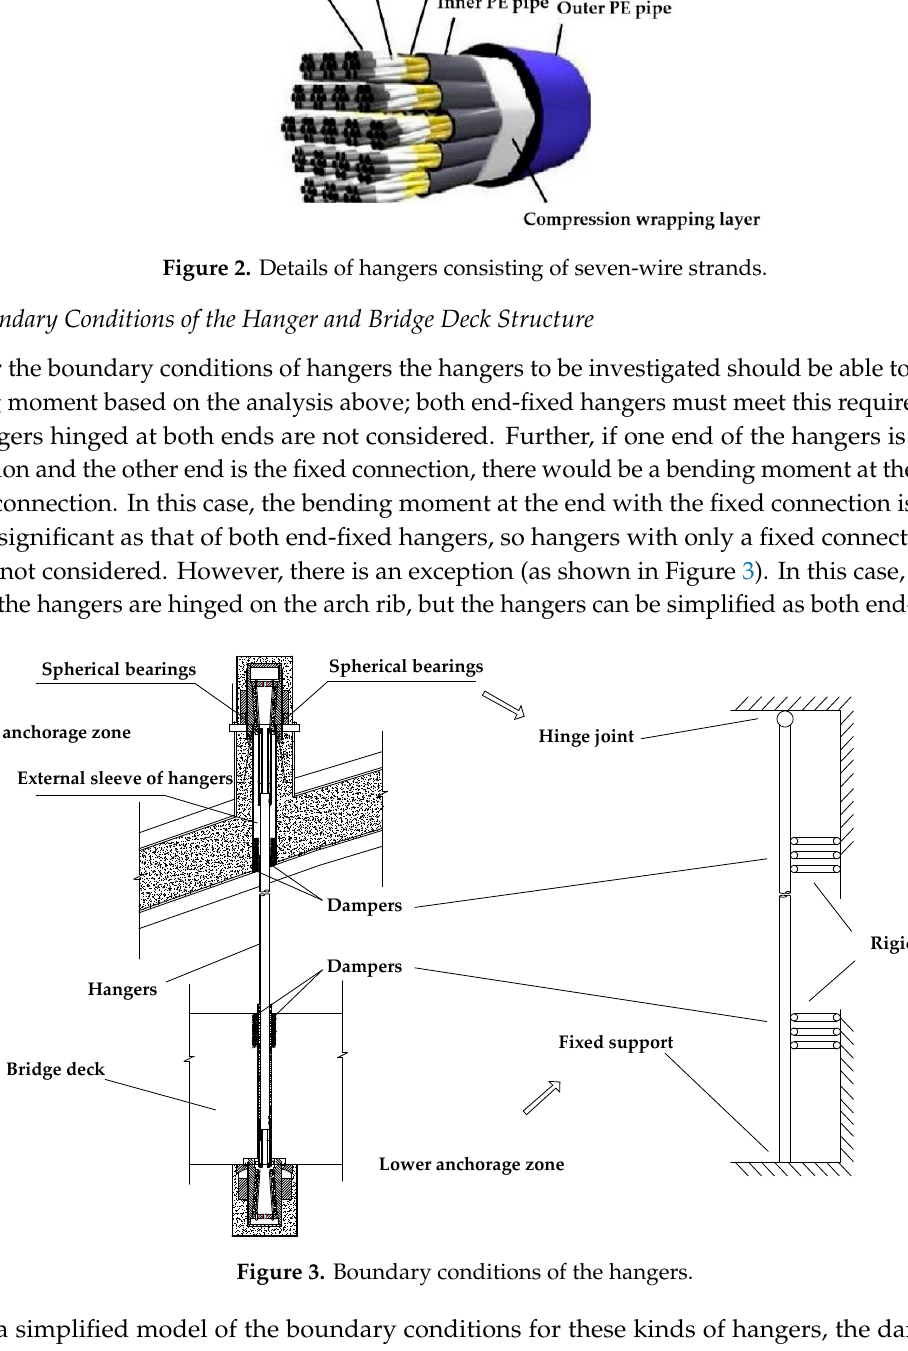
Figure 2. Details of hangers consisting of seven-wire strands.